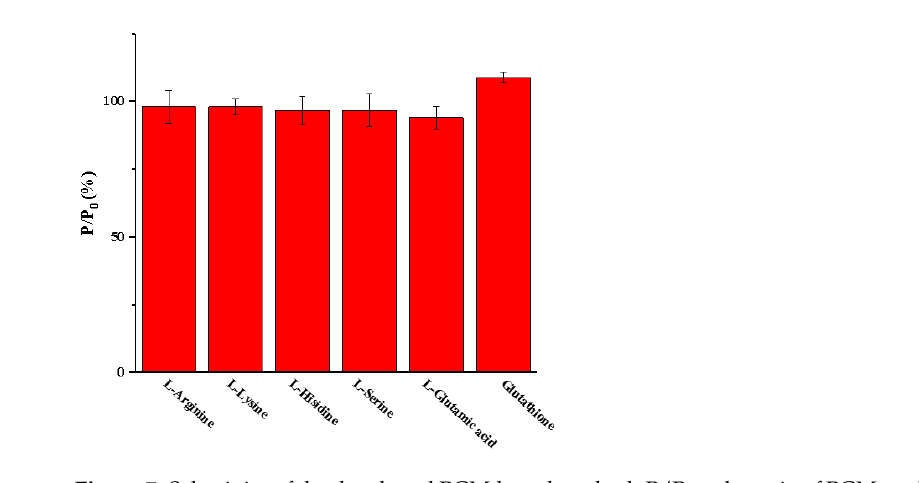
with/without interfering substances.